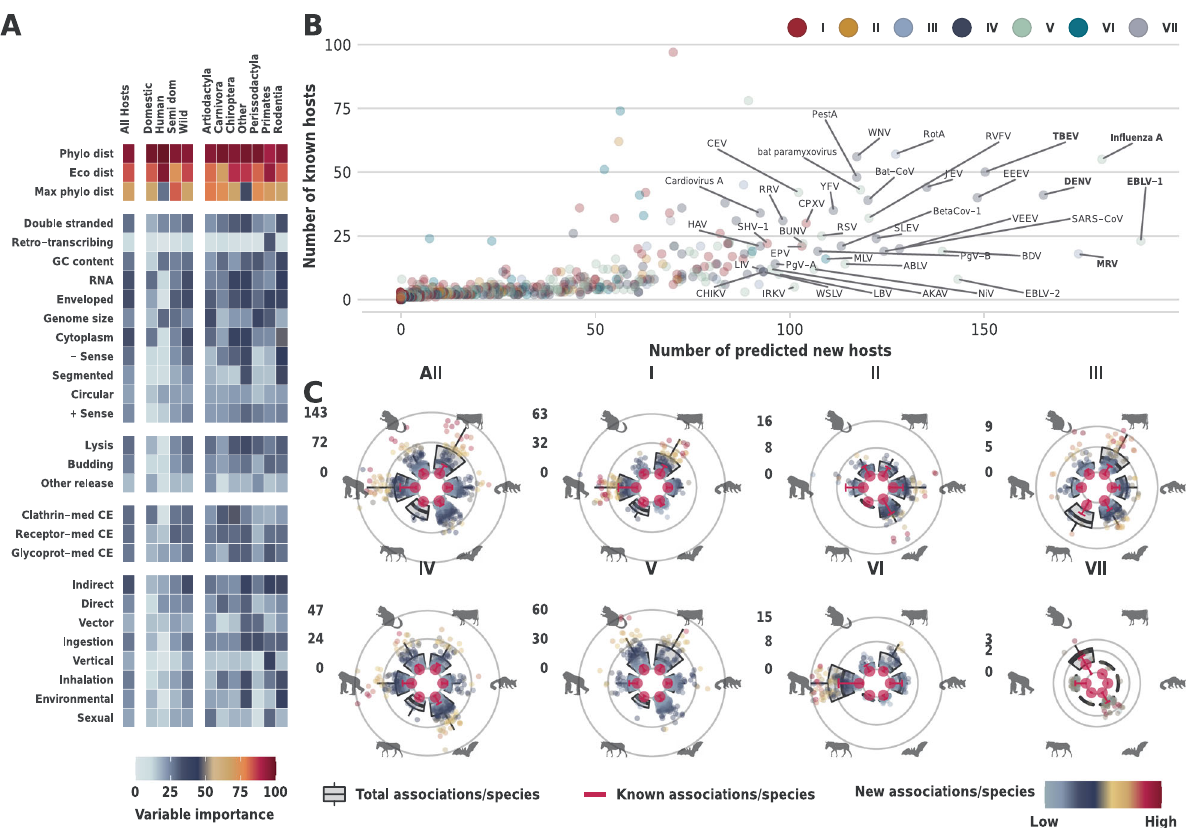
Fig. 2 Results (viruses). Panel A Variable importance (relative contribution) of viral traits to mammalian perspective models. Variable importance is calculated for each constituent ensemble ( n = 699) of our mammalian perspective (median of a suite of 50 replicate models, trained with viral features, with SMOTE sampling), and then aggregated (mean) per each reported group (columns). Panel B – Number of known and new mammalian species associated with each virus. Rabies lyssavirus was excluded from panel B to allow for better visualisation. Top 40 (by number of new hosts) are labelled. Species in bold have over 150 predicted hosts (Supplementary Data 3 lists details of these viruses including CI). Panel C Predicted number of viruses per species of wild and semi-domesticated mammals (group by mammalian order). Following orders (clockwise) are presented: Artiodactyla , Carnivora , Chiroptera , Perissodactyla , Primates , and Rodentia . Source of the silhouette graphics is PhyloPic.org. (Supplementary Data 4 lists aggregated results per mammalian order). Circles represent each mammalian species (with predicted viruses > 0), coloured by number of known viruses previously not associated with this species. Boxplots indicate median (centre), the 25th and 75th percentiles (bounds of box) and inter quantile range (whiskers) and are aggregated at the order level. Large red circles with error bars (90% CI) illustrate the median number of known viruses per species in each order. Number of species presented ( n ) is as follows: All = 1293 ( Artiodactyla = 104, Carnivora = 177, Chiroptera = 548, Perissodactyla = 11, Primates = 171, and Rodentia = 282); Group I = 666 (94, 109, 156, 10, 160, 137); Group II = 371 (32, 120, 111, 1, 54, 53); Group III = 410 (87,62,123,9,51,78); Group IV = 739 (98, 102, 221, 9, 148, 161); Group V = 1129 (87, 173, 528, 8, 107, 226); Group VI = 358 (55, 64, 30, 6, 139, 64); and Group VII = 110 (3,2,53,1,43,8). Supplementary Fig. 8 presents results derived with research effort into mammalian hosts and viruses included in the constituent models trained in the viral and mammalian perspectives,